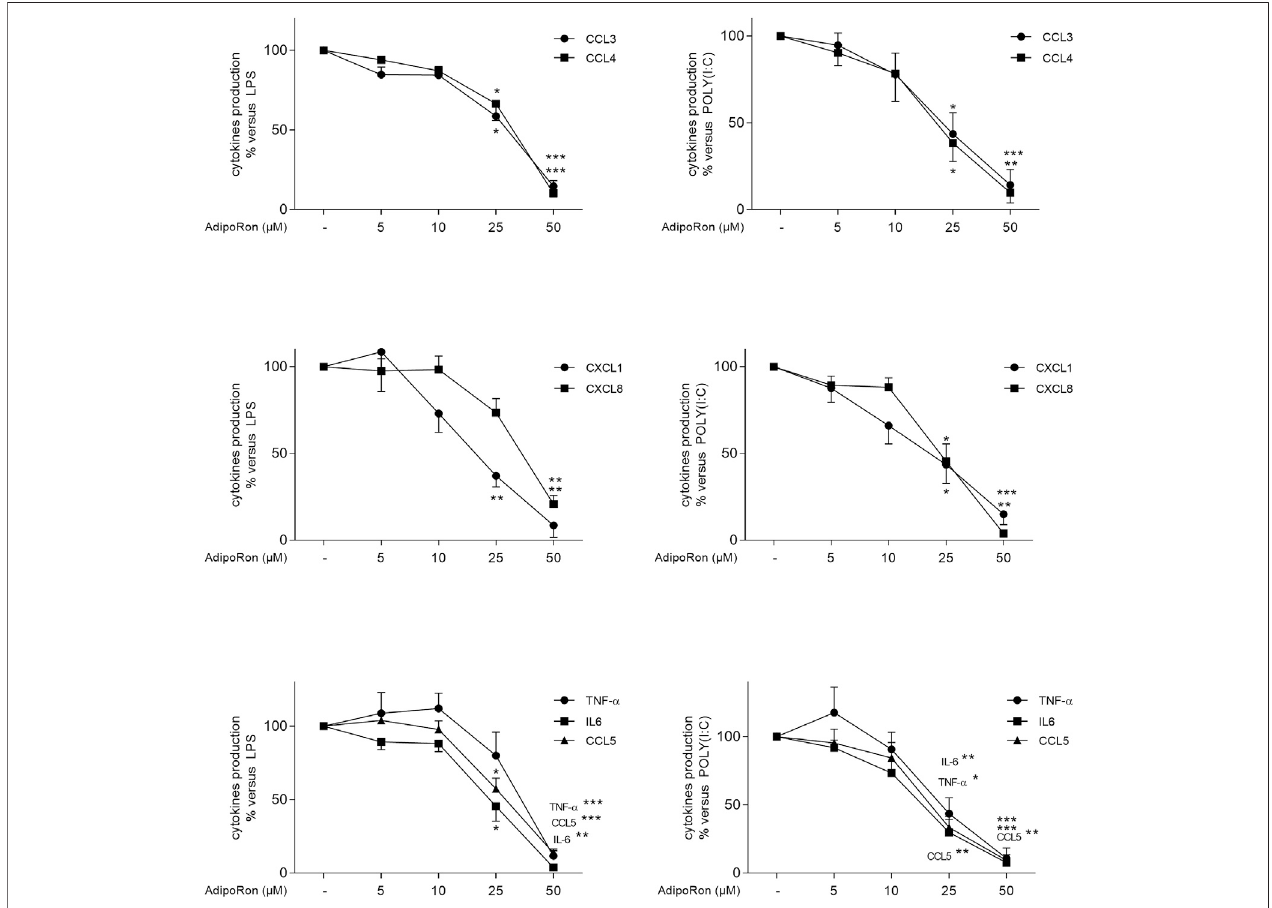
FIGURE 6 | Inhibitory effects of AdipoRon on the LPS- or poly(I:C)-induced cytokine release by human LMs. Macrophages were incubated with LPS (10 ng ml − 1 , left column) or poly (I:C) (10 µg ml − 1 , right column) in the absence or presence of AdipoRon (5, 10, 25, and 50 µM). Data are expressed as a percentage with respect to LPSorpoly(I:C)-inducedproduction. Resultsareshownasthemean ± SEMof5 – 9differentexperiments. Asterisksindicatesigni fi canteffects ofAdipoRon withrespect to LPS or poly (I:C) alone (*: p < 0.05; **: p < 0.01; ***: p < 0.001).